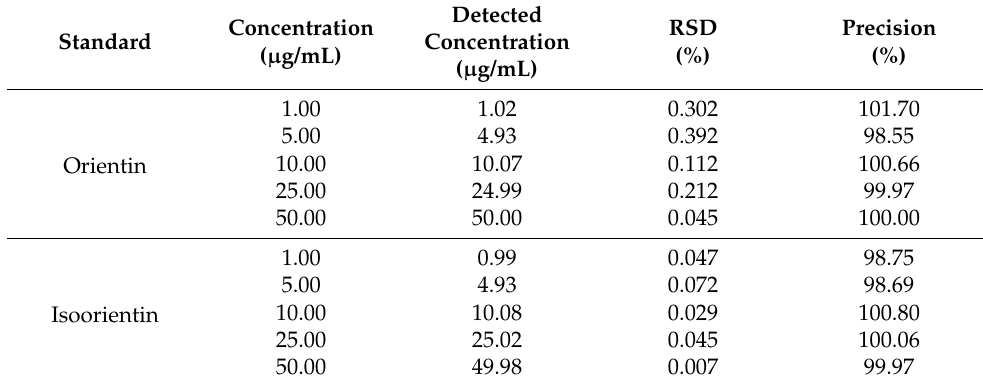
Table 1. Intra-day precision for orientin and isoorientin using the HPLC–PDA method ( n = 3).